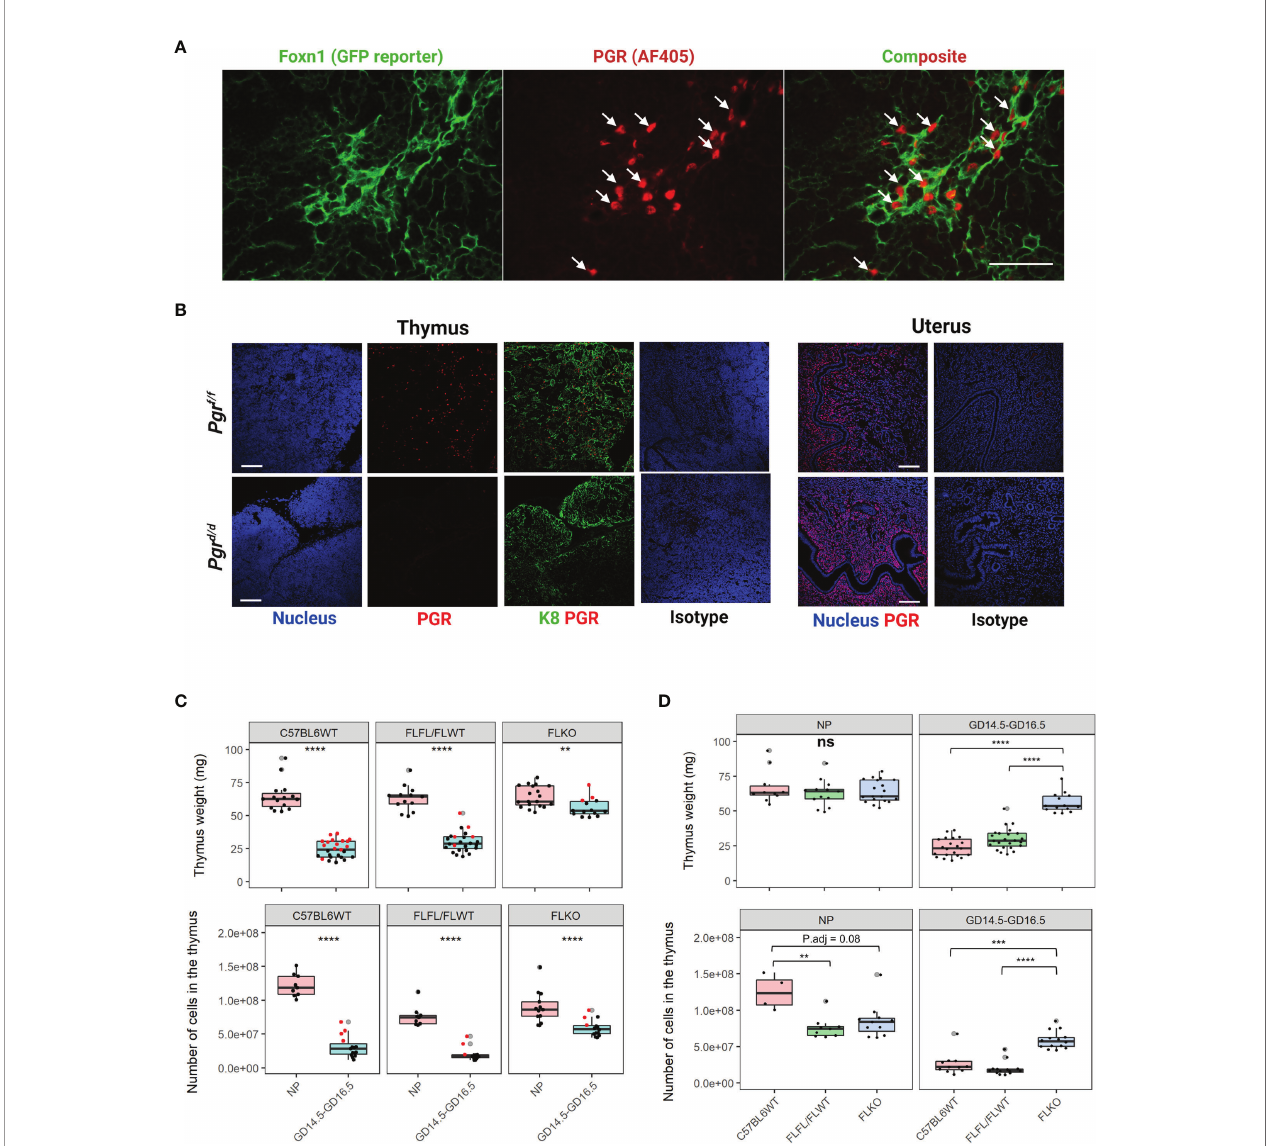
FIGURE 4 | Conditional deletion of Pgr gene from the Foxn1+ thymic epithelial cells prevents thymic involution in pregnancy. (A) Nuclear progesterone receptor (PGR) colocalizes with Foxn1+ Thymic epithelial cells (TECs) at GD6.5. Alexa fl our 405 was used as a secondary antibody. PGR is pseudo-colored red to provide contrast to the GFP+. 400x magni fi cation, scale bar = 50 m m. (B) Immuno fl uorescence staining to detect PGR protein con fi rms the conditional deletion of Pgr in the thymus at GD16.5 of Pgr d/d females. PGR expression is intact in the NP female uterus of both Pgr f/f controls and Pgr d/d animals. Magni fi cation at 200x. Scale bar = 100 m m, (C) Thymic weight (Top) and cellularity (Bottom) in NP and GD16.5 C57BL6WT, Pgr f/f / Pgr f/+ (FLFL/FLWT) or Pgr d/d (FLKO) females. Red dots = GD14.5. (D) Thymic weight (Top) and cellularity (Bottom) in C57BL6WT, Pgr f/f / Pgr f/+ (FLFL/FLWT) or Pgr d/d (FLKO) between NP and pregnant (GD14.5 - GD16.5) females. Each dot represents one mouse. Statistical analysis was performed using non-parametric Wilcoxon test (C) or Kruskal-Wallis test followed by Dunn ’ s test for post- hoc assessment with Bonferroni correction (D) . P<0.05 deemed signi fi cant. **p < 0.001, ***p < 0.0005, ****p < 0.00001, ns, non-signi fi